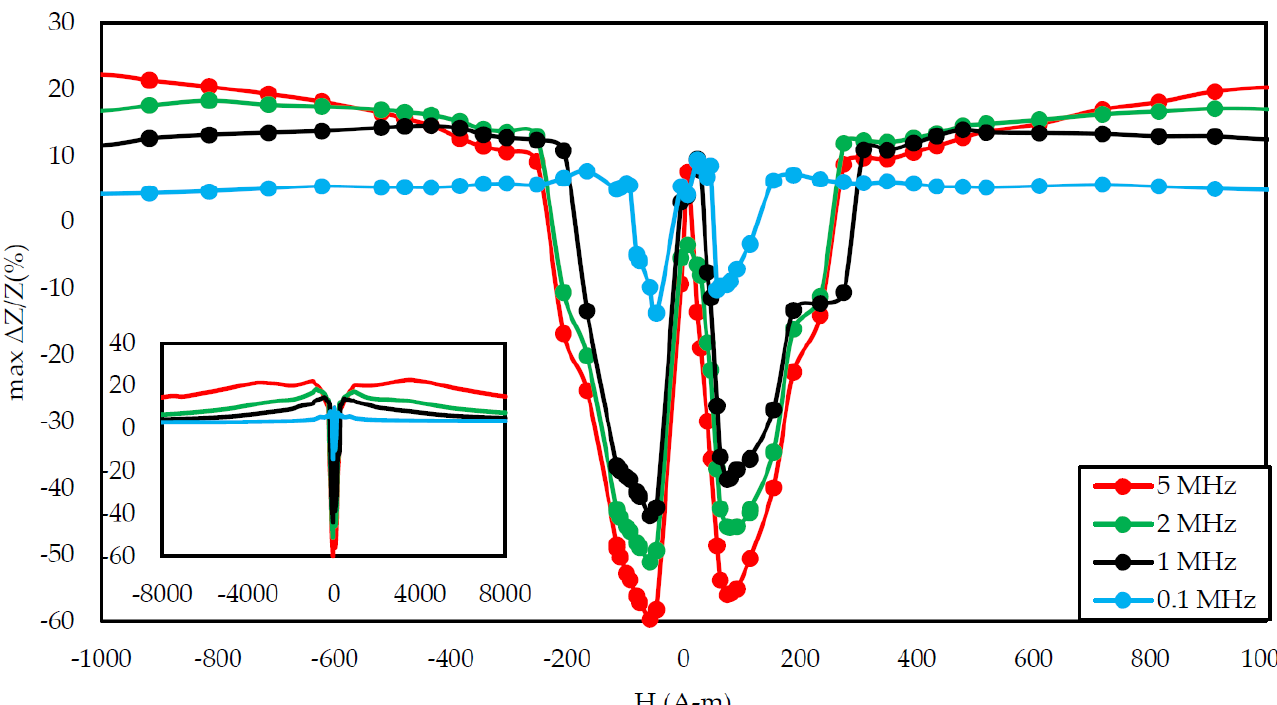
Figure 8. Dependence of max change of impedance ratio in a function of magnetizing field for different driving frequencies for the annealed by a 700 mA current sample.